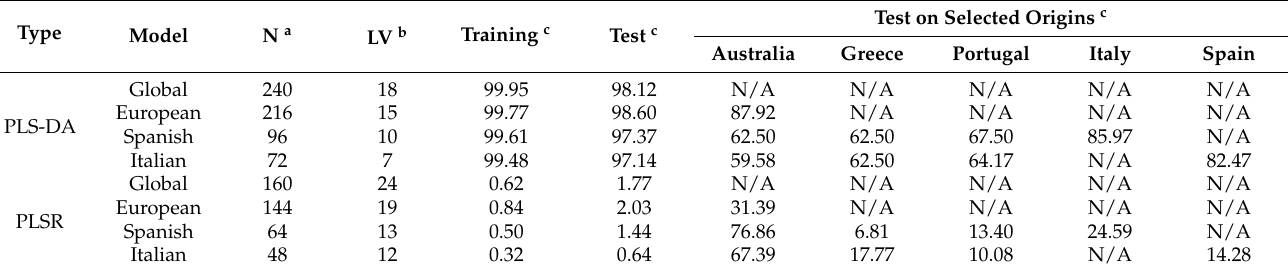
Table 1. EVOO adulteration prediction by UV-Vis spectra according to geographical origins.